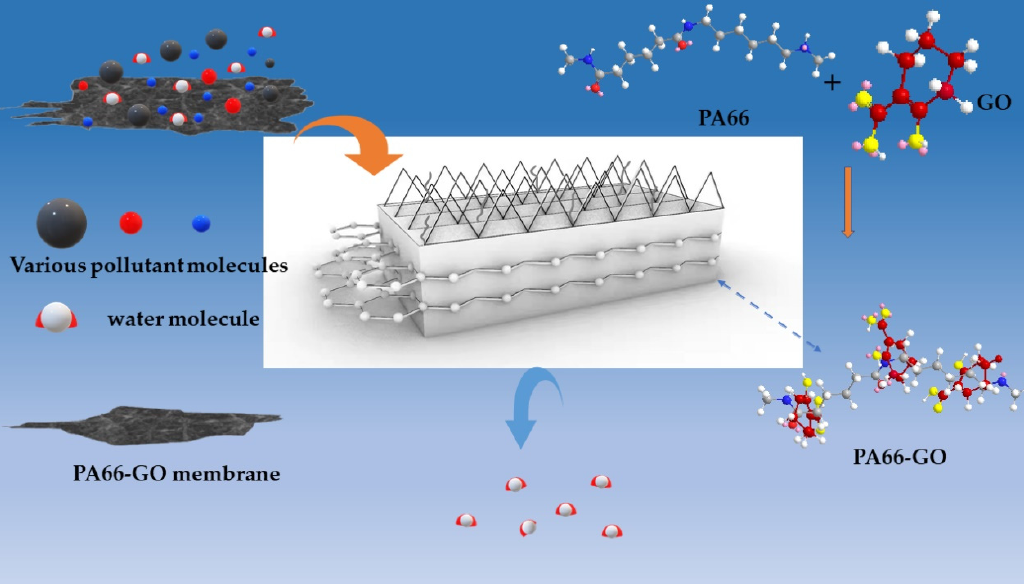
Figure 16. Schematic diagram of anti-fouling mechanism.